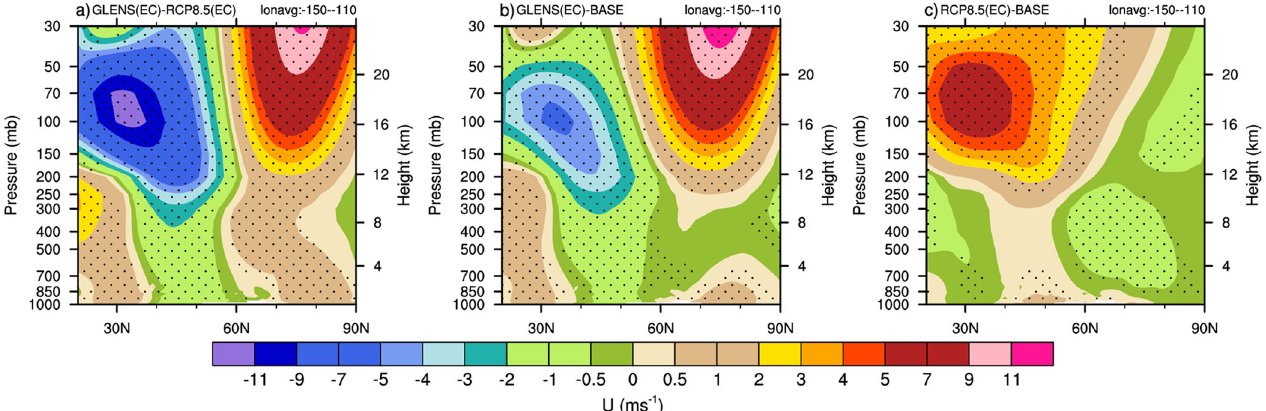
Fig. 2 Cool season zonal wind for analysis scenarios. Cool season (October – March) mean zonal wind (U) changes for three analysis periods averaged over 110 – 150°W. GLENS (EC) - RCP8.5 (EC) ( a ), GLENS (EC) - BASE ( b ), RCP8.5 (EC) - BASE ( c ). Stippling is computed at 95% signi fi cance with a Student ’ s T